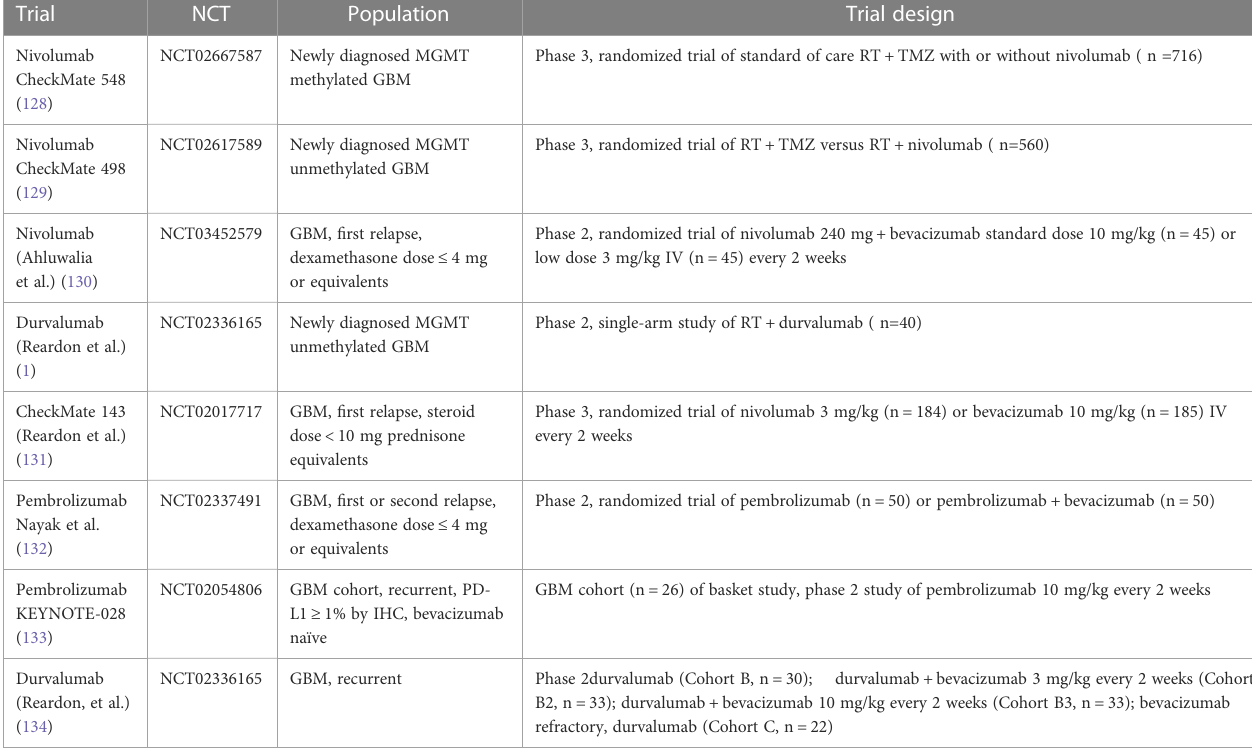
TABLE 3 Phase II/III trials of checkpoint inhibitors in glioblastoma.